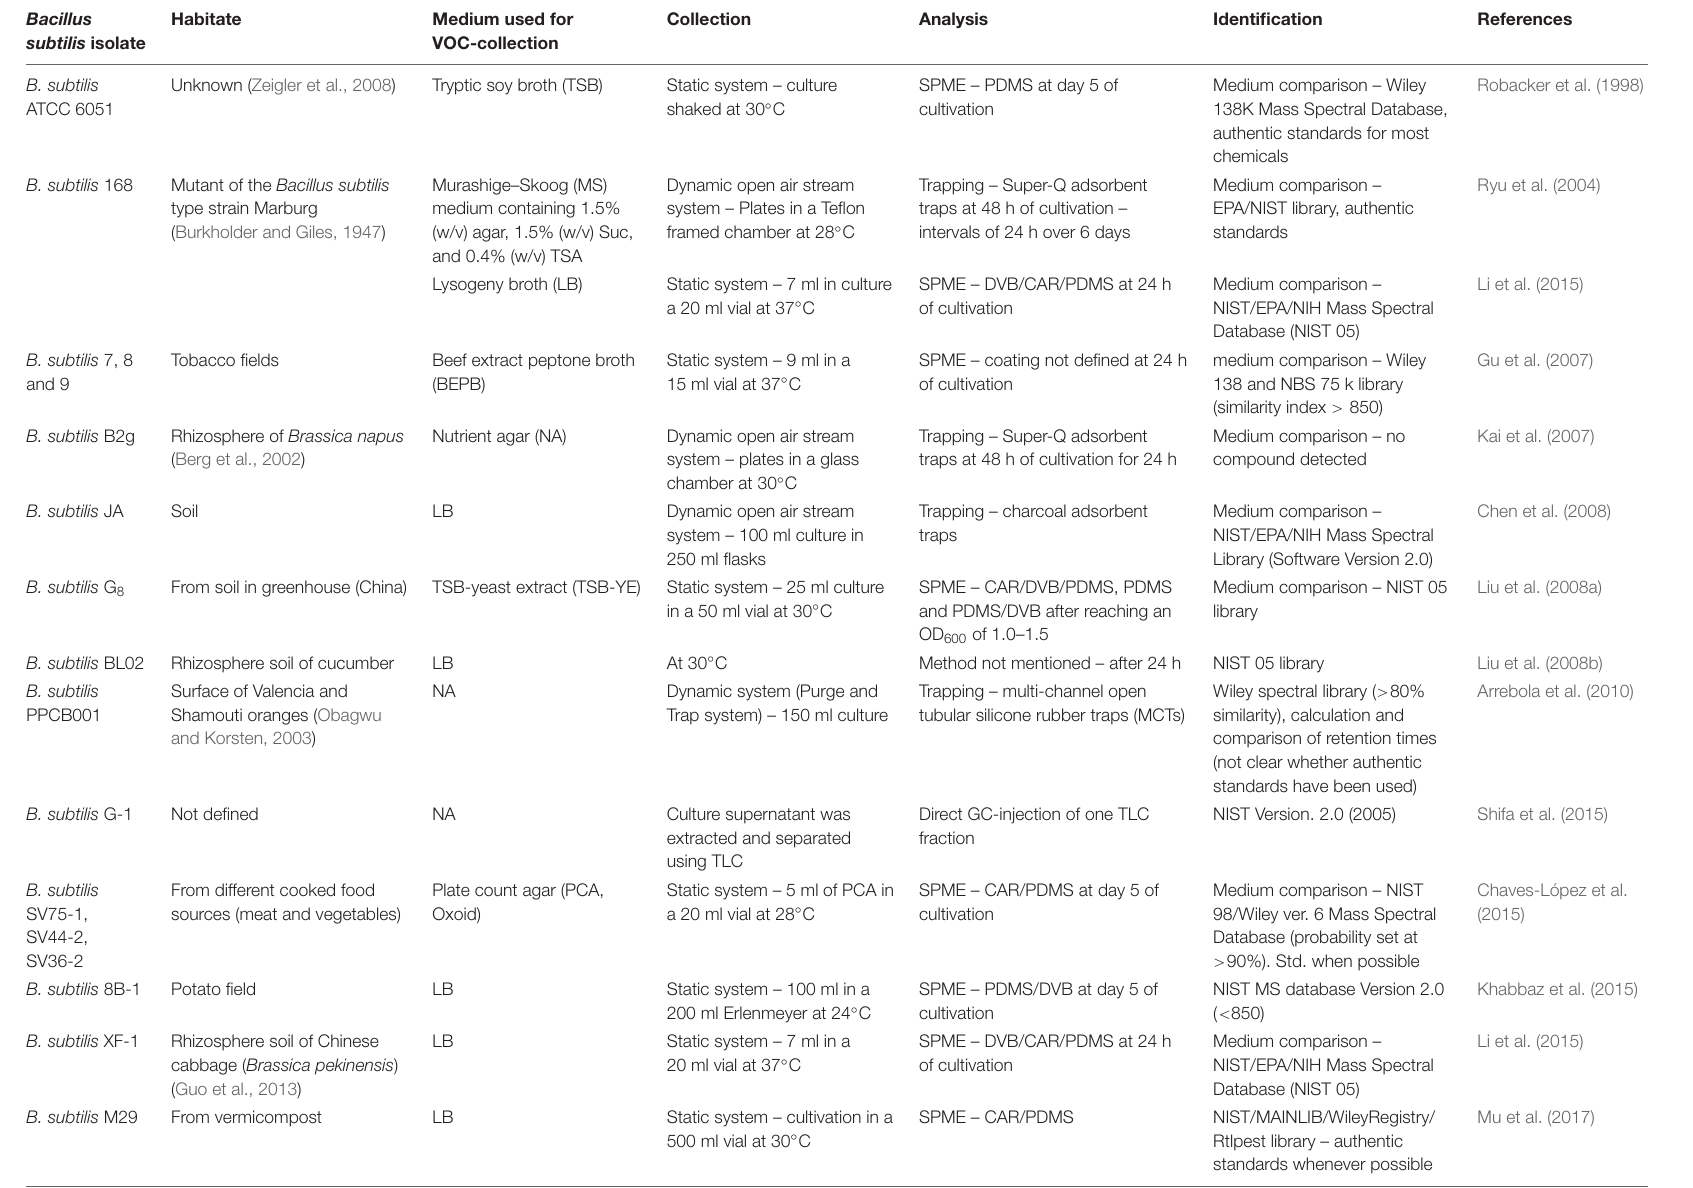
TABLE 1 | Investigated Bacillus subtilis